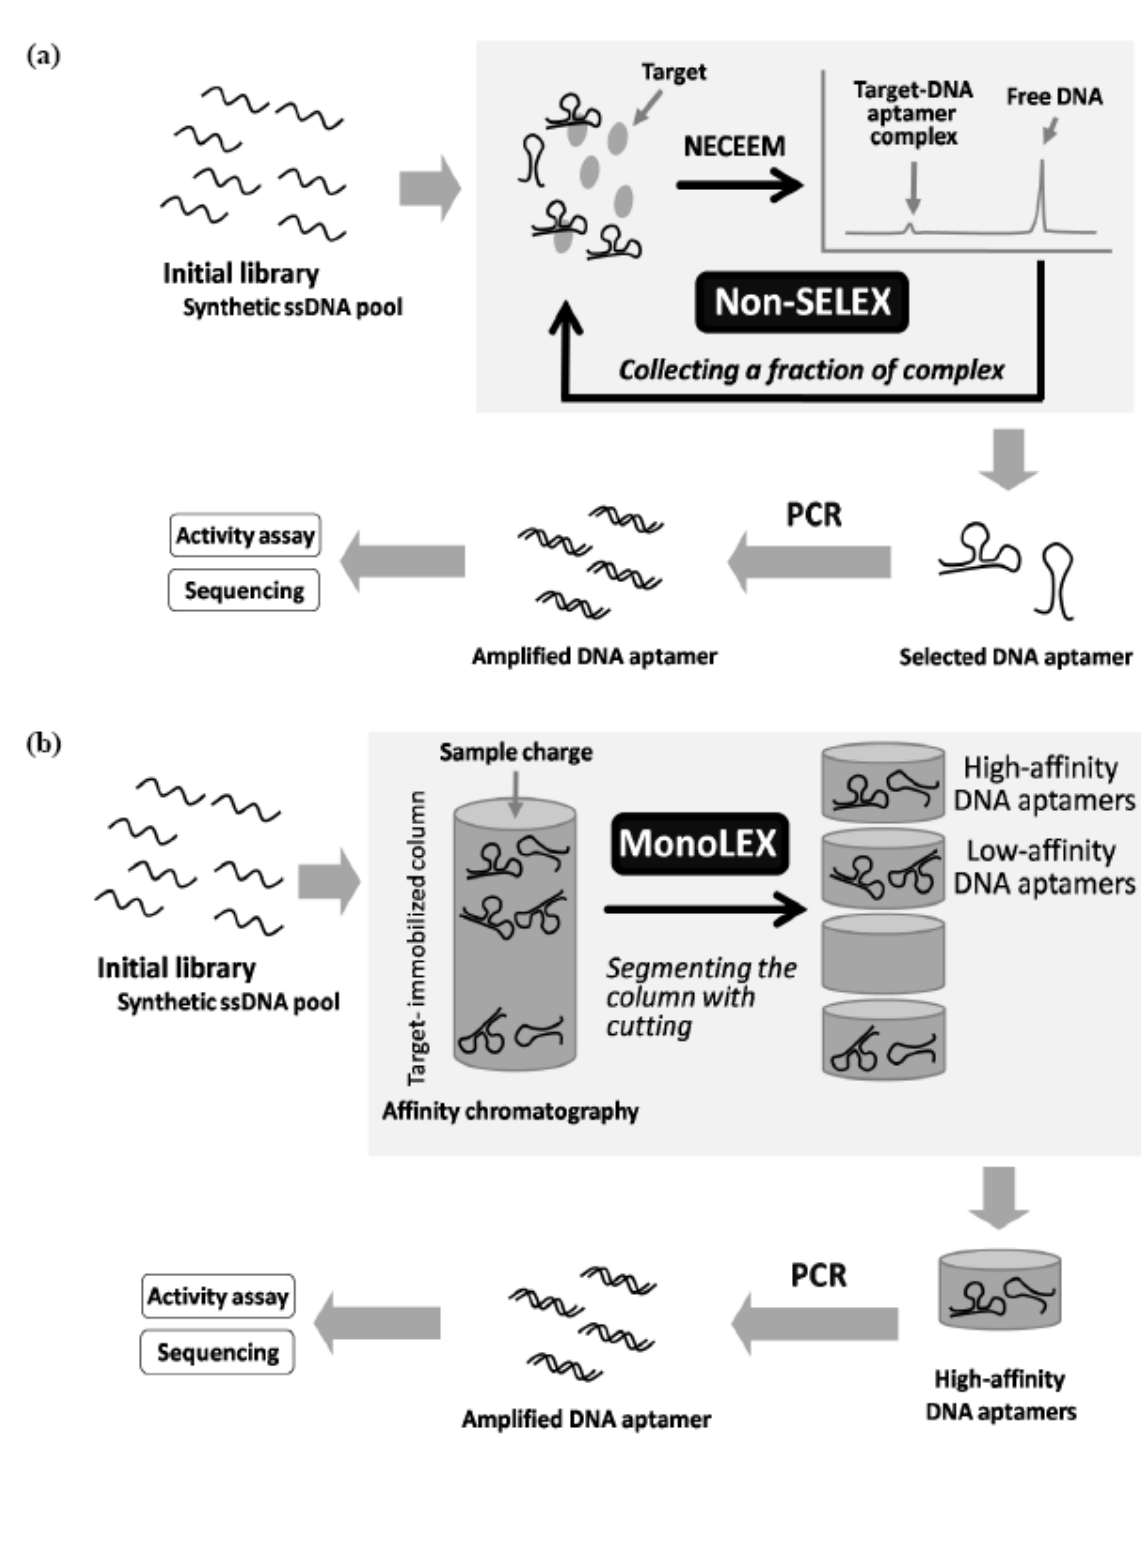
Figure 5. (a) Schematic illustration of random screening of DNA aptamers by non-SELEX selection. (b) Schematic illustration of MonoLEX random screening of DNA